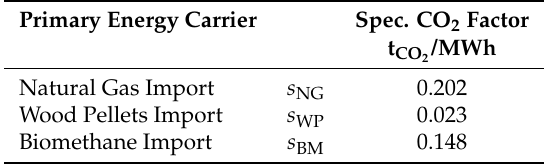
Table 1. Specific CO 2 emissions of the relevant primary energy sources according to Reference